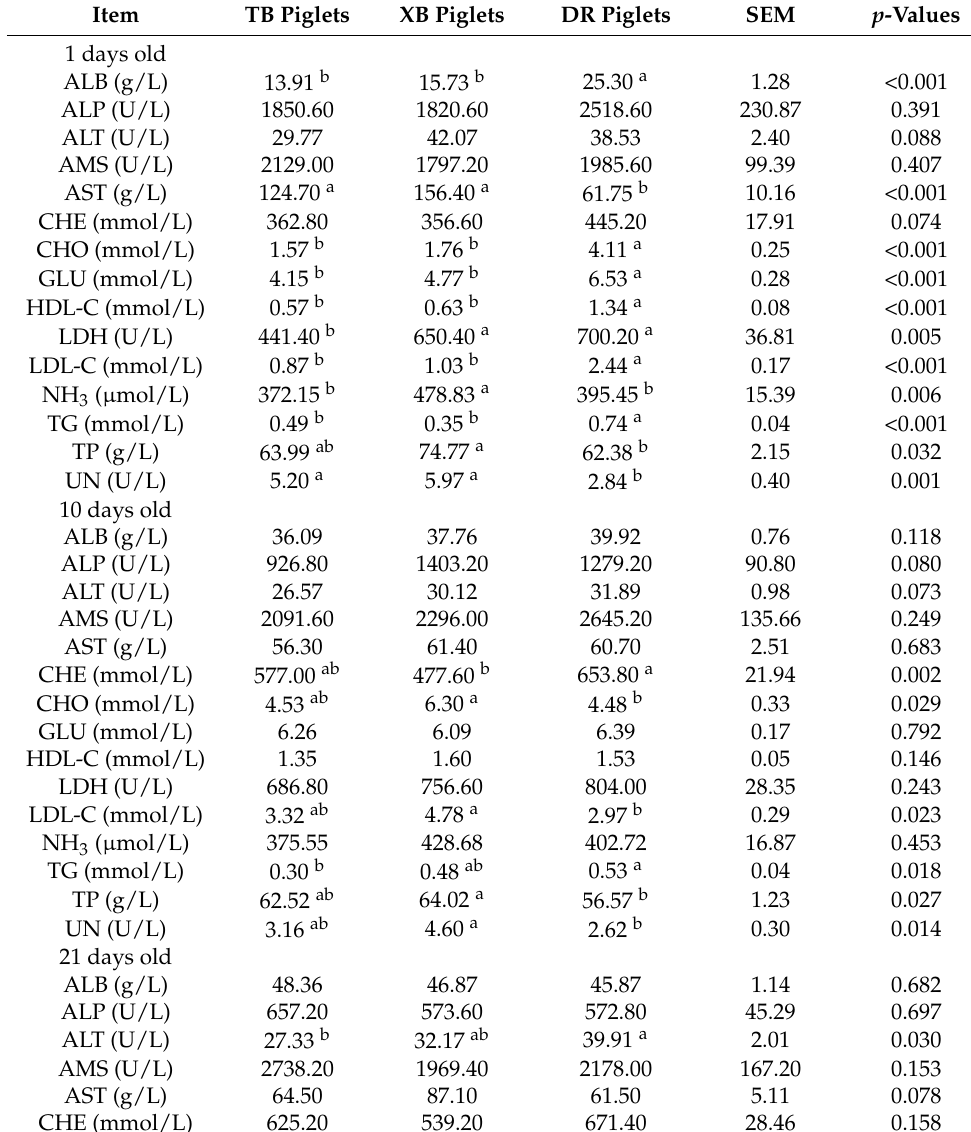
Table 2. Differences in plasma biochemical parameters of piglets at different ages. Item TB Piglets XB Piglets DR